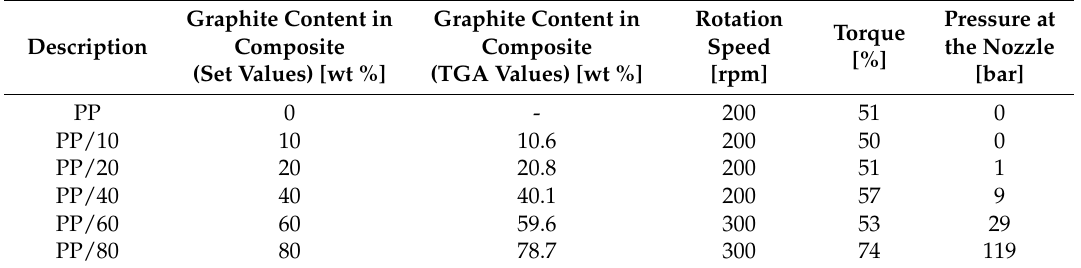
Table 2. Melt mixing process parameters of graphite